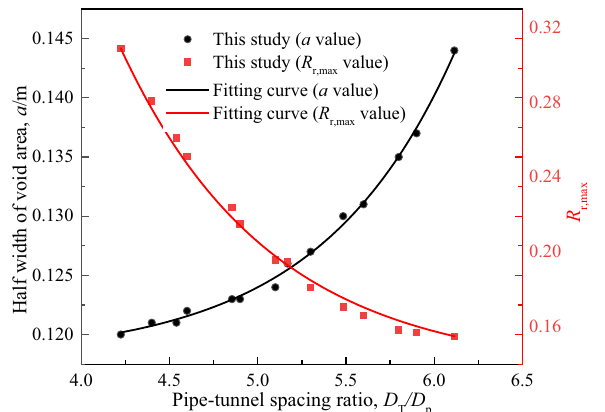
Figure 17. Relative detachment extent between pipeline and soil under different pipe-tunnel spacing